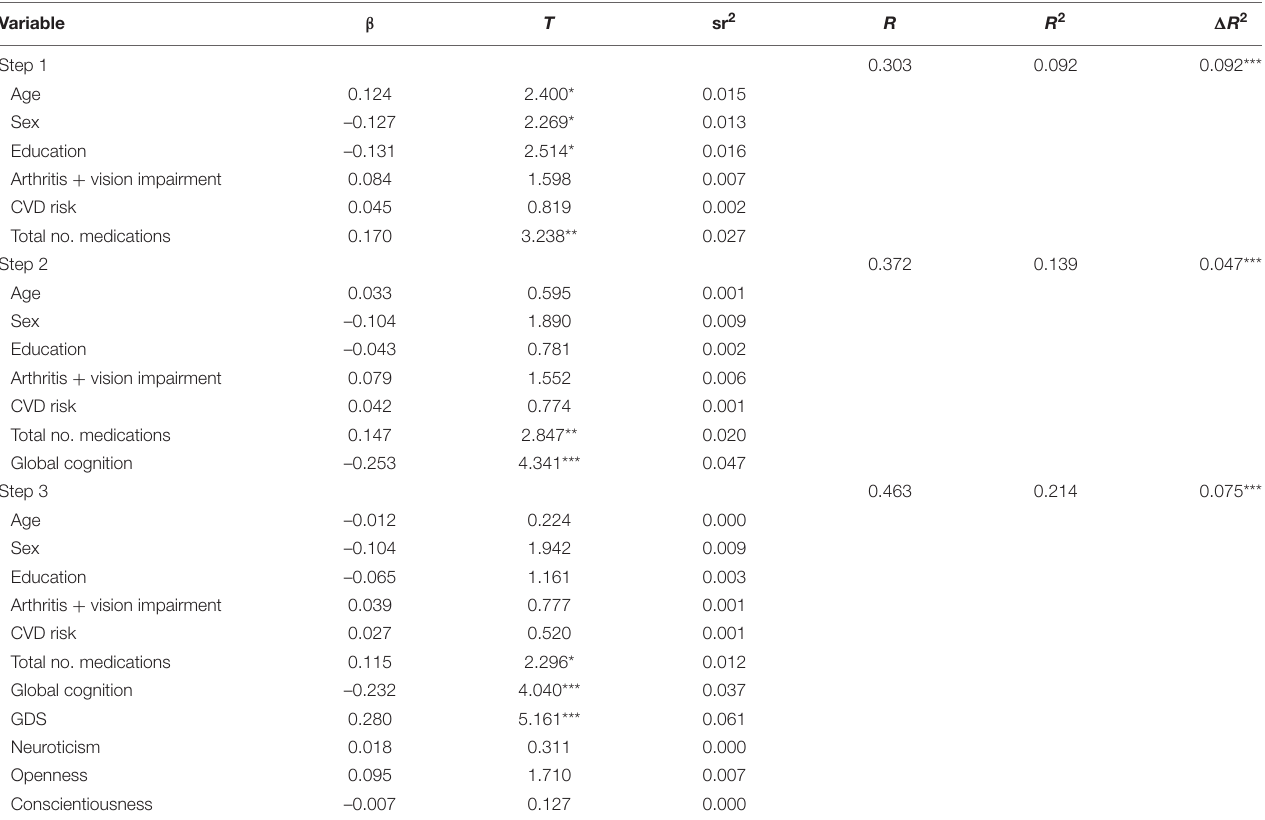
TABLE 3 | Hierarchical linear regression predicting informant-report